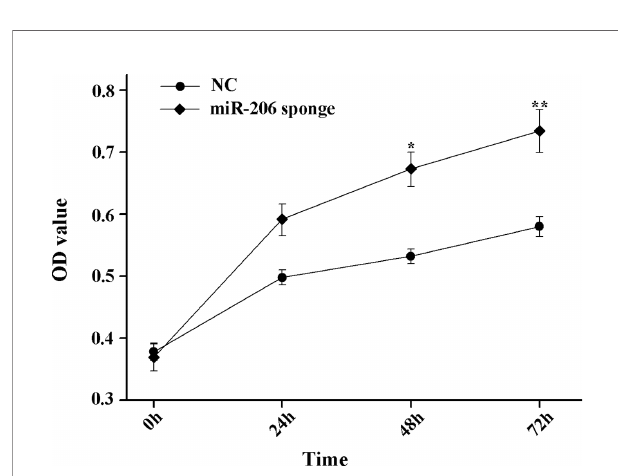
FIGURE 7 | MiR-206 sponge promotes melanocytes proliferation. Cell proliferation was measured with OD value using a cell counting kit-8 (CCK-8) assay (* P < 0.05, ** P <